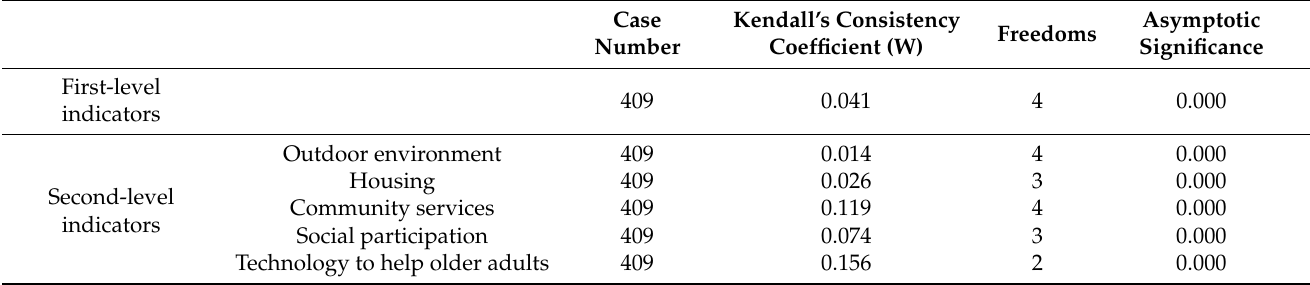
Table 8. Kendall consistency test